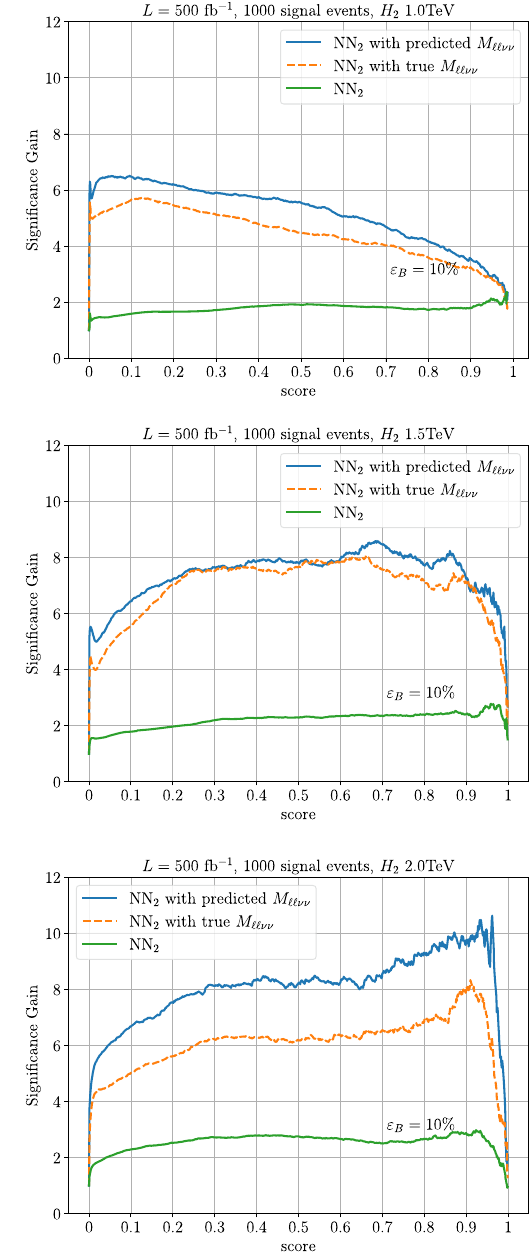
(upper row), 1.5 (center row) and 2 TeV (lower row) Higgs mass. The systematic uncertainty is fixed at